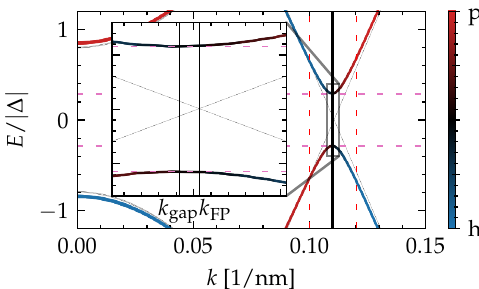
Figure A1. The quasiparticle spectrum of a top-proximitized TI nanoribbon near a local minimum of the gap (indicated by horizontal pink dashed lines), which develops near the Fermi point of the subband crossing of the spectrum with ∆ = 0. A narrow interval around each Fermi point (indicated by vertical red dashed lines) is considered to obtain fast convergence towards the value of the spectral gap with an adaptive search algorithm over k values in that